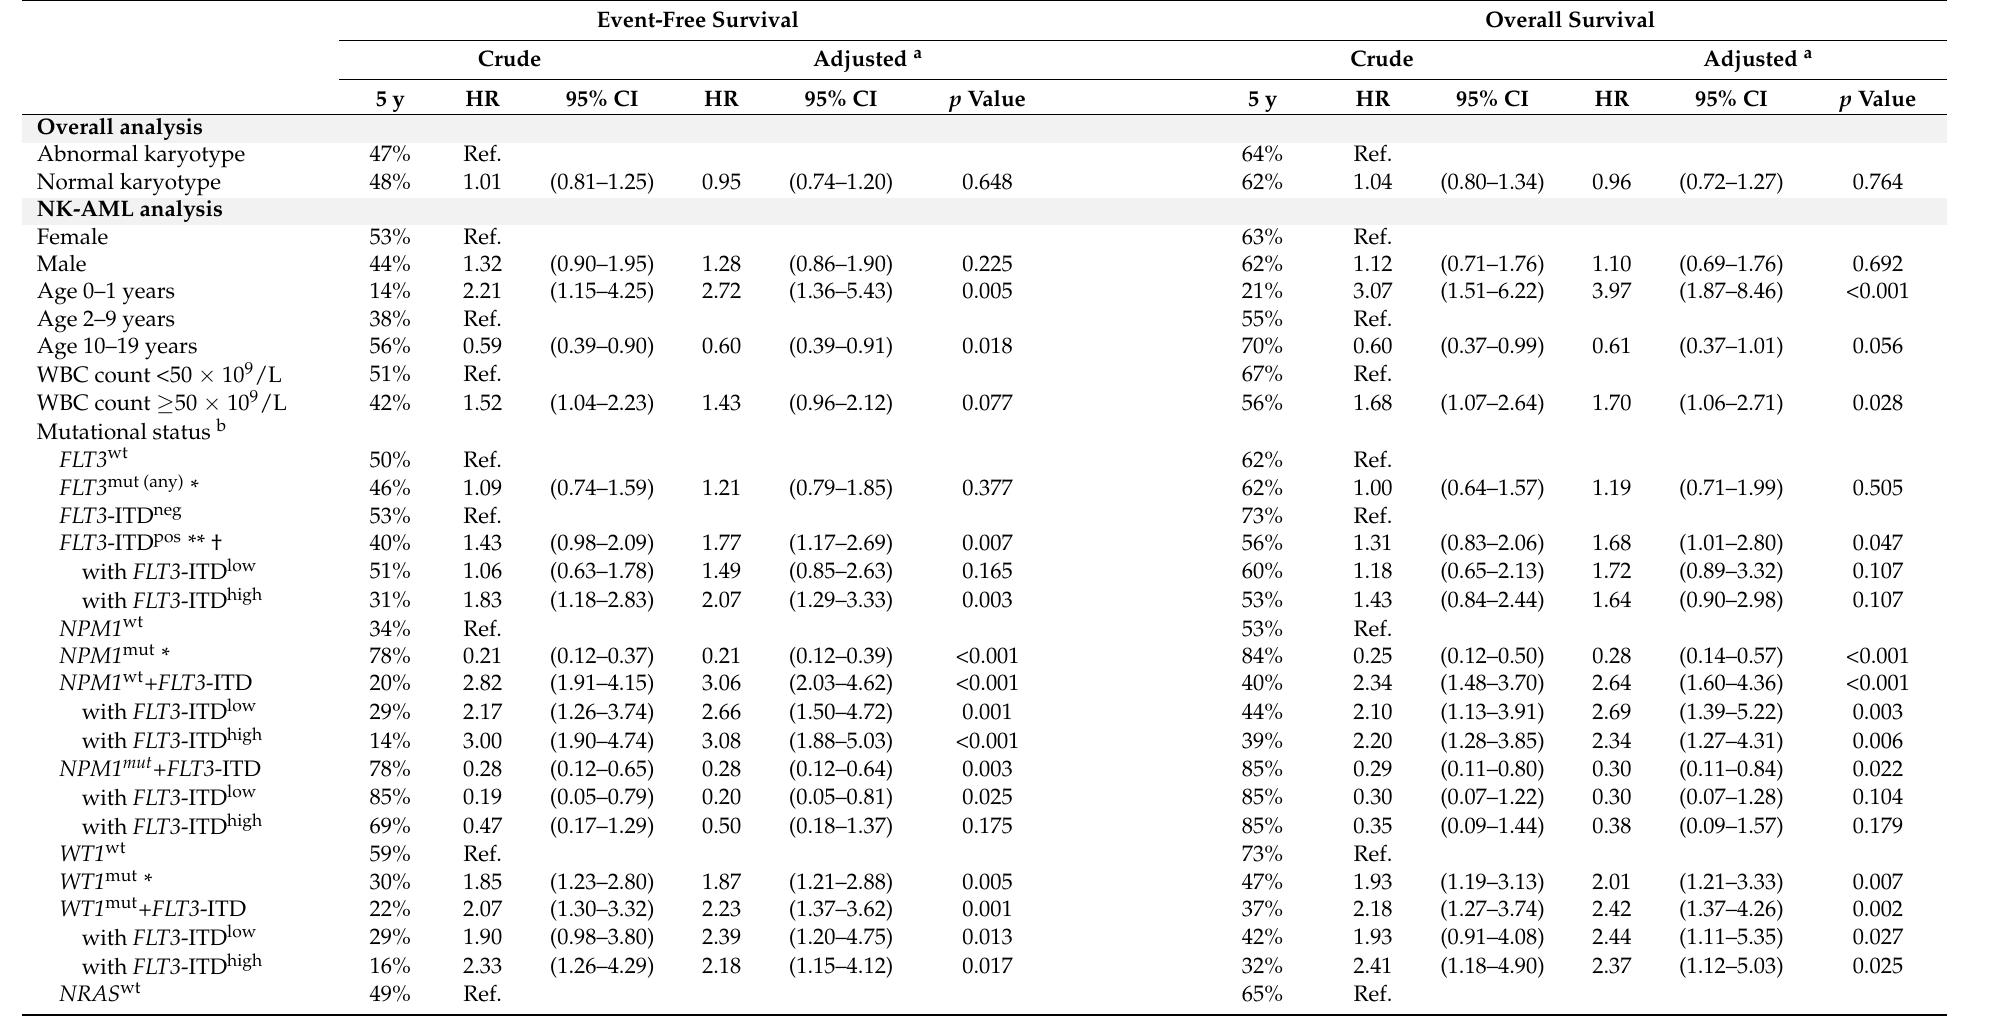
Table 2. Uni- and multivariate analysis of event-free and overall survival in